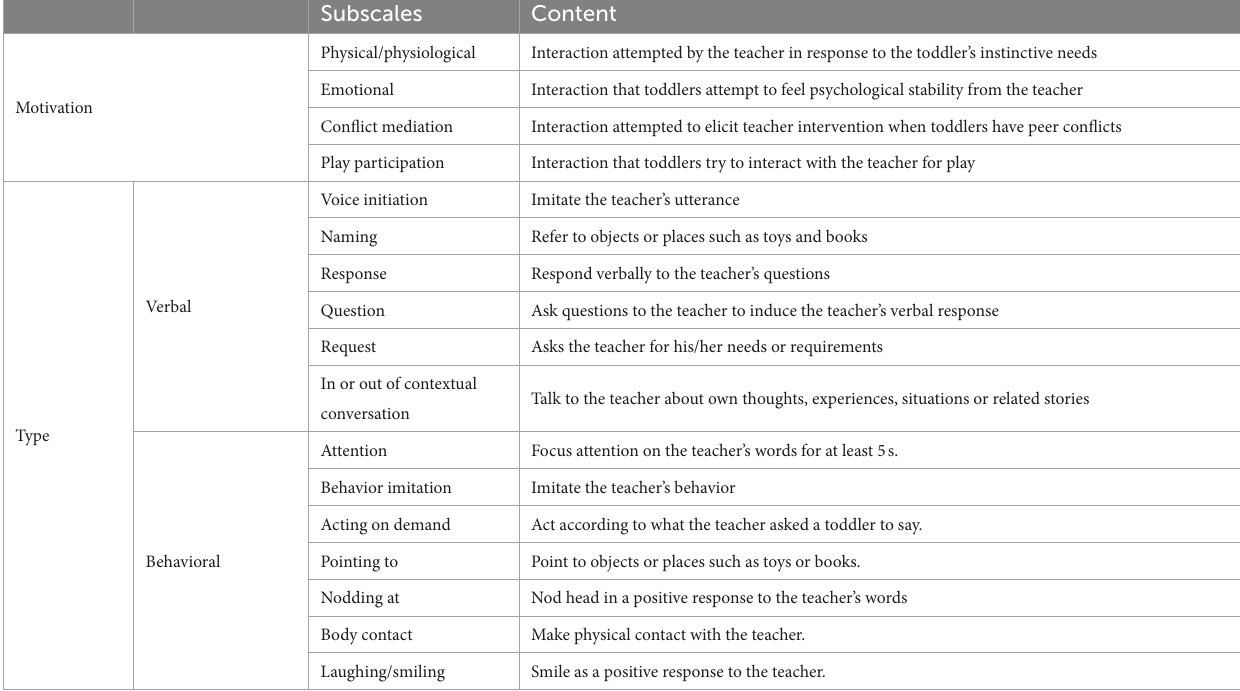
TABLE 2 The definition of toddler–teacher interaction.